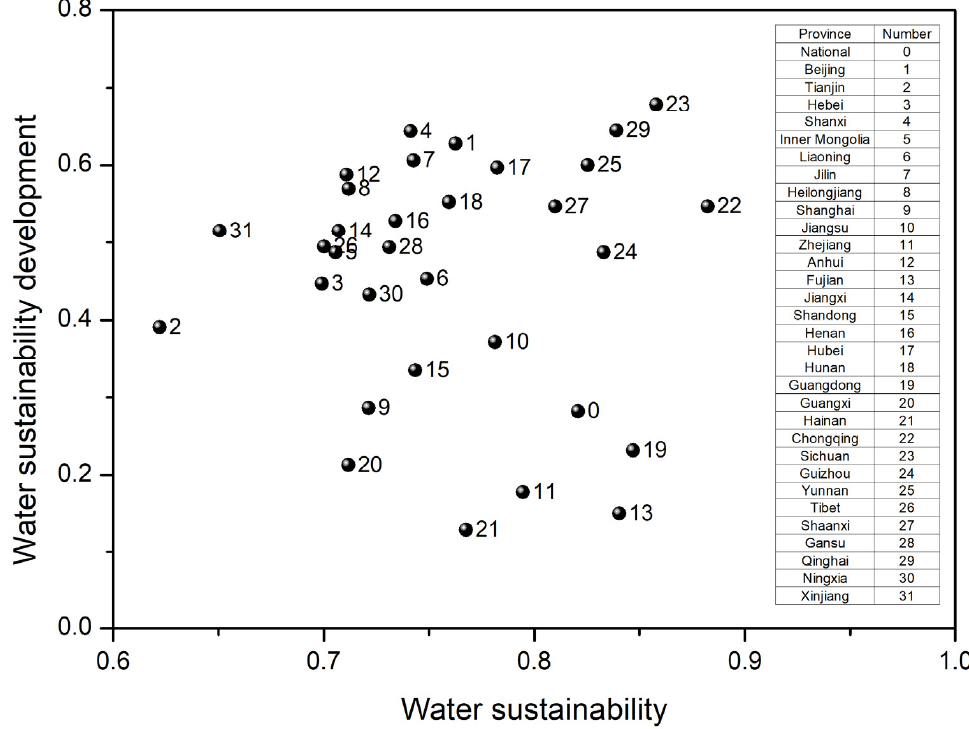
Figure 3. Water sustainability and development scatters for provinces.